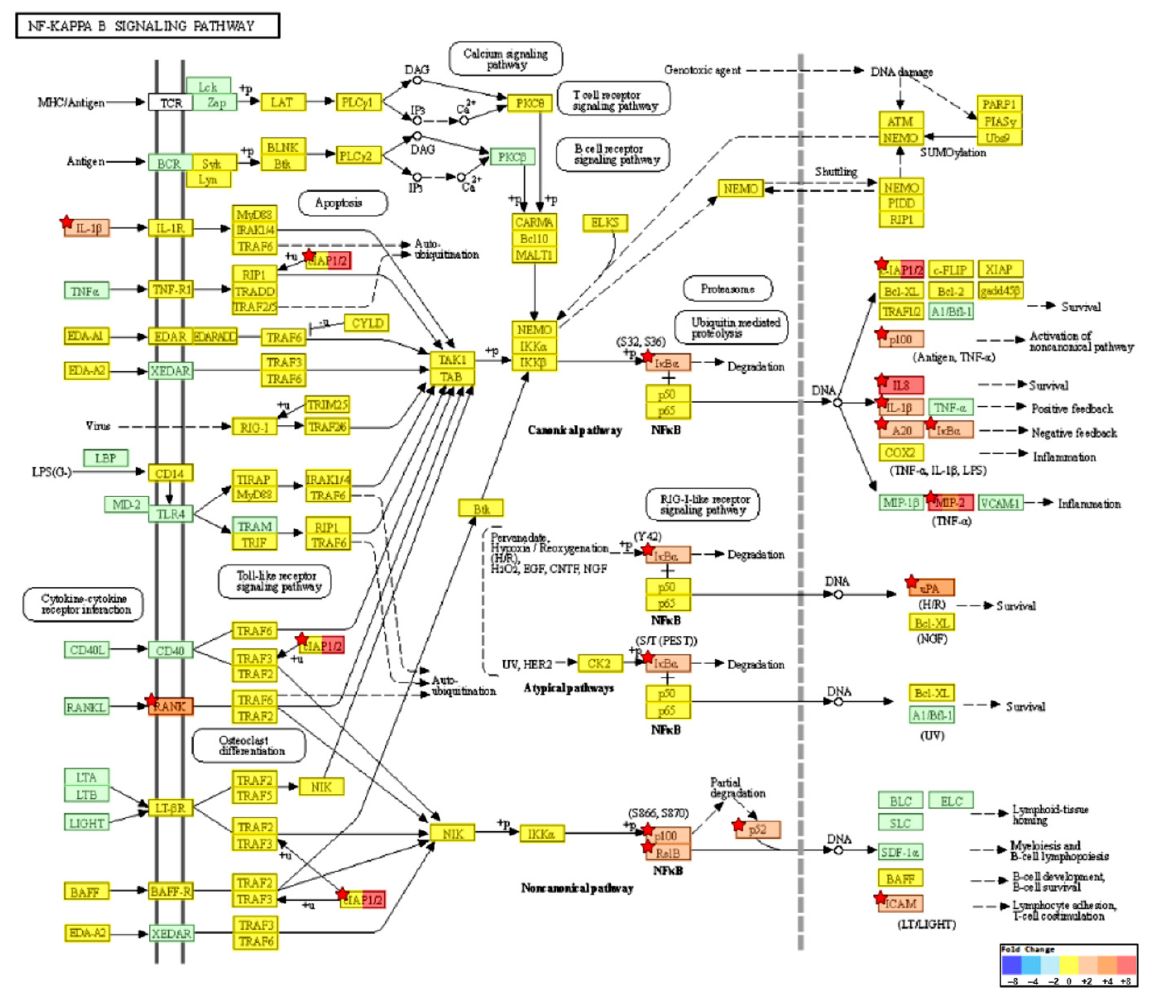
Figure 7. NF- κ B signaling pathway (KEGG map, has04064) of differentially expressed genes from CotG-p75 stimulated Caco-2 cells. Fold change value is expressed based on the color key. Modules with significantly selected DEGs are marked with a red star symbol. Blue indicates modules in which down-regulated genes are mapped. Red indicates modules in which up-regulated genes are mapped. Green indicates modules made up of genes present in a species whose expression cannot be determined.